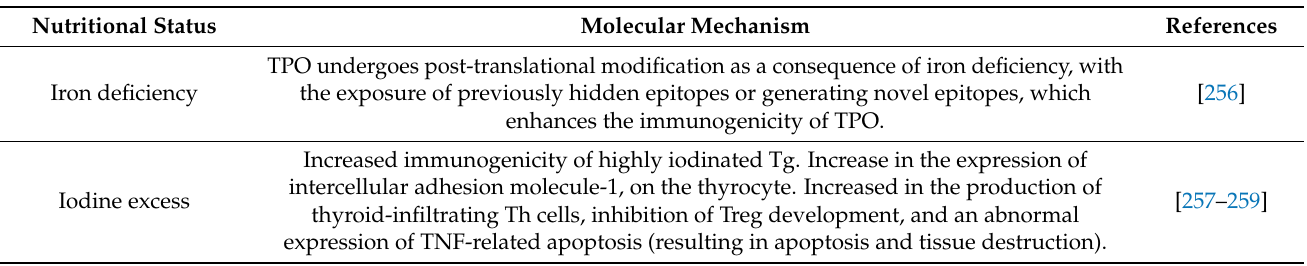
Table 7. Nutritional factors related to